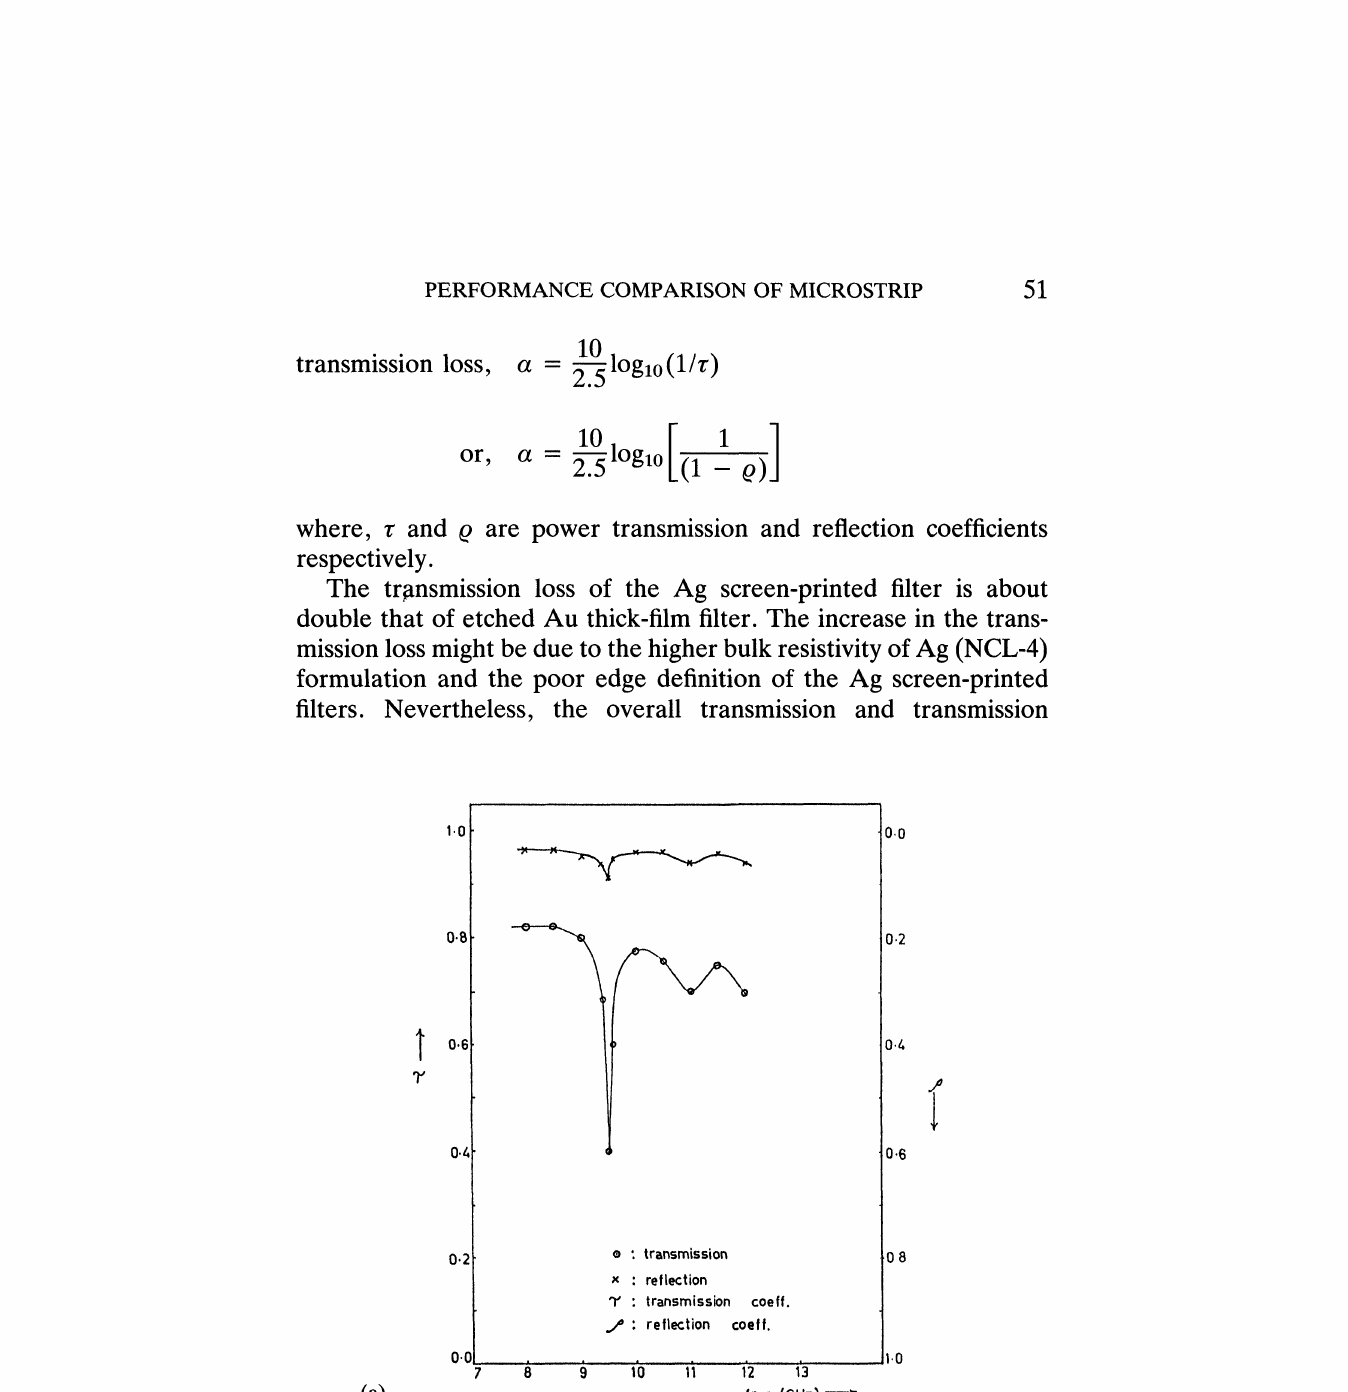
FIGURE 2 Transmission and reflection curves for (a) thin film electroplated Cr-Cu microstrip filter, (b) thin film ion-plated Cu microstrip filter, (c) Ag thick film microstrip